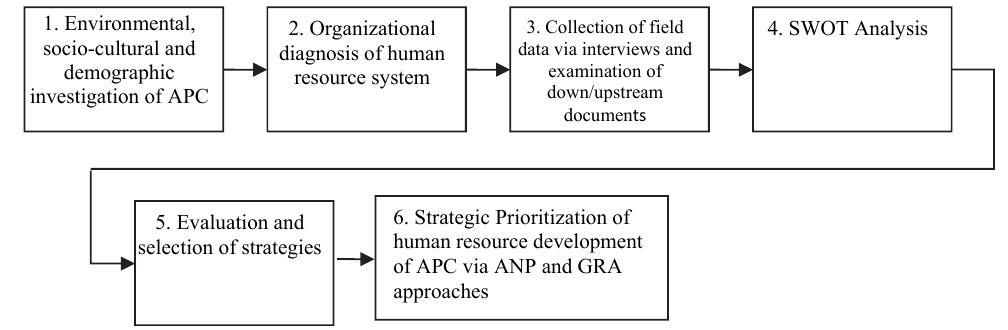
Fig. 1 Steps of human resource development investigation in